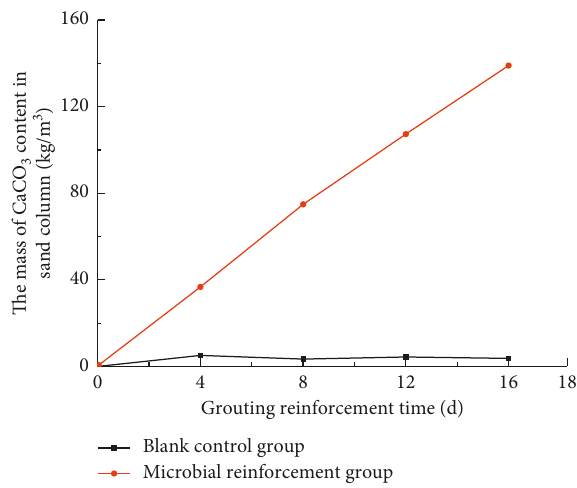
Figure 12: The changes in CaCO 3 production of uranium tailings reinforced by MICP as function of